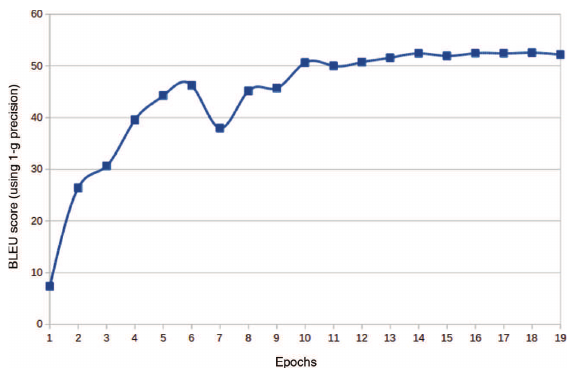
Figure 6: BLEU Score Achieved by NMT System at Different Epochs.